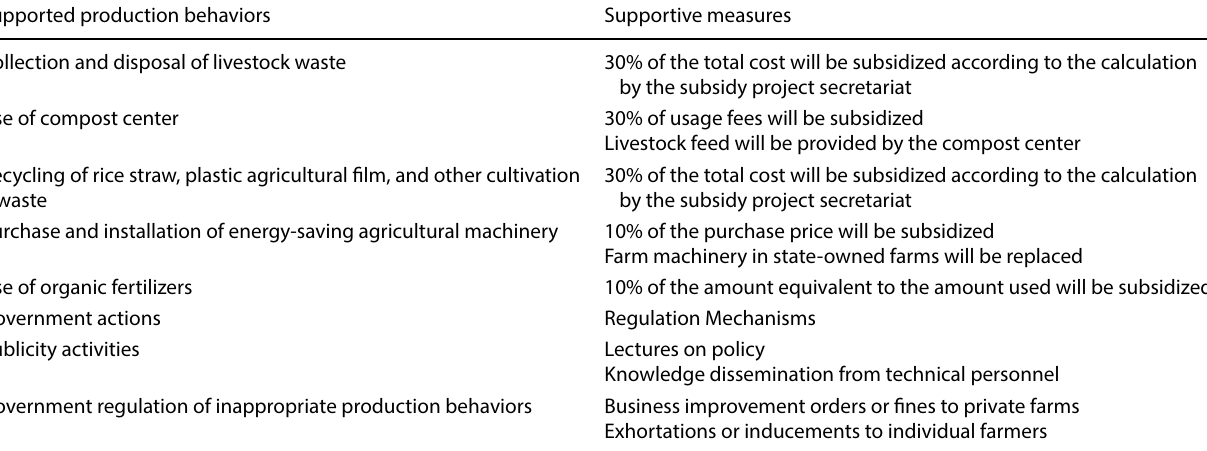
Table 2 Supportive measures and regulation mechanisms of pilot policies Supported production